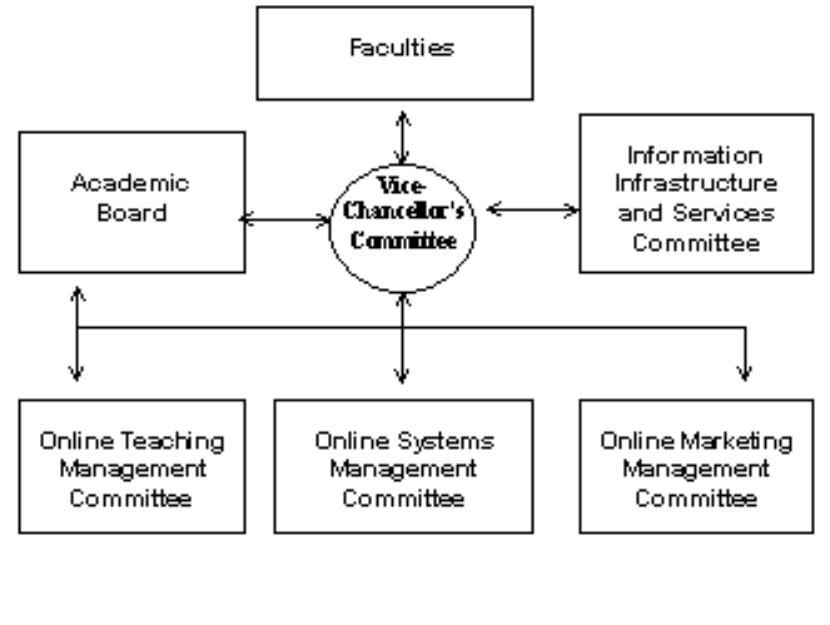
Figure 4: Management Structure of Online Initiatives